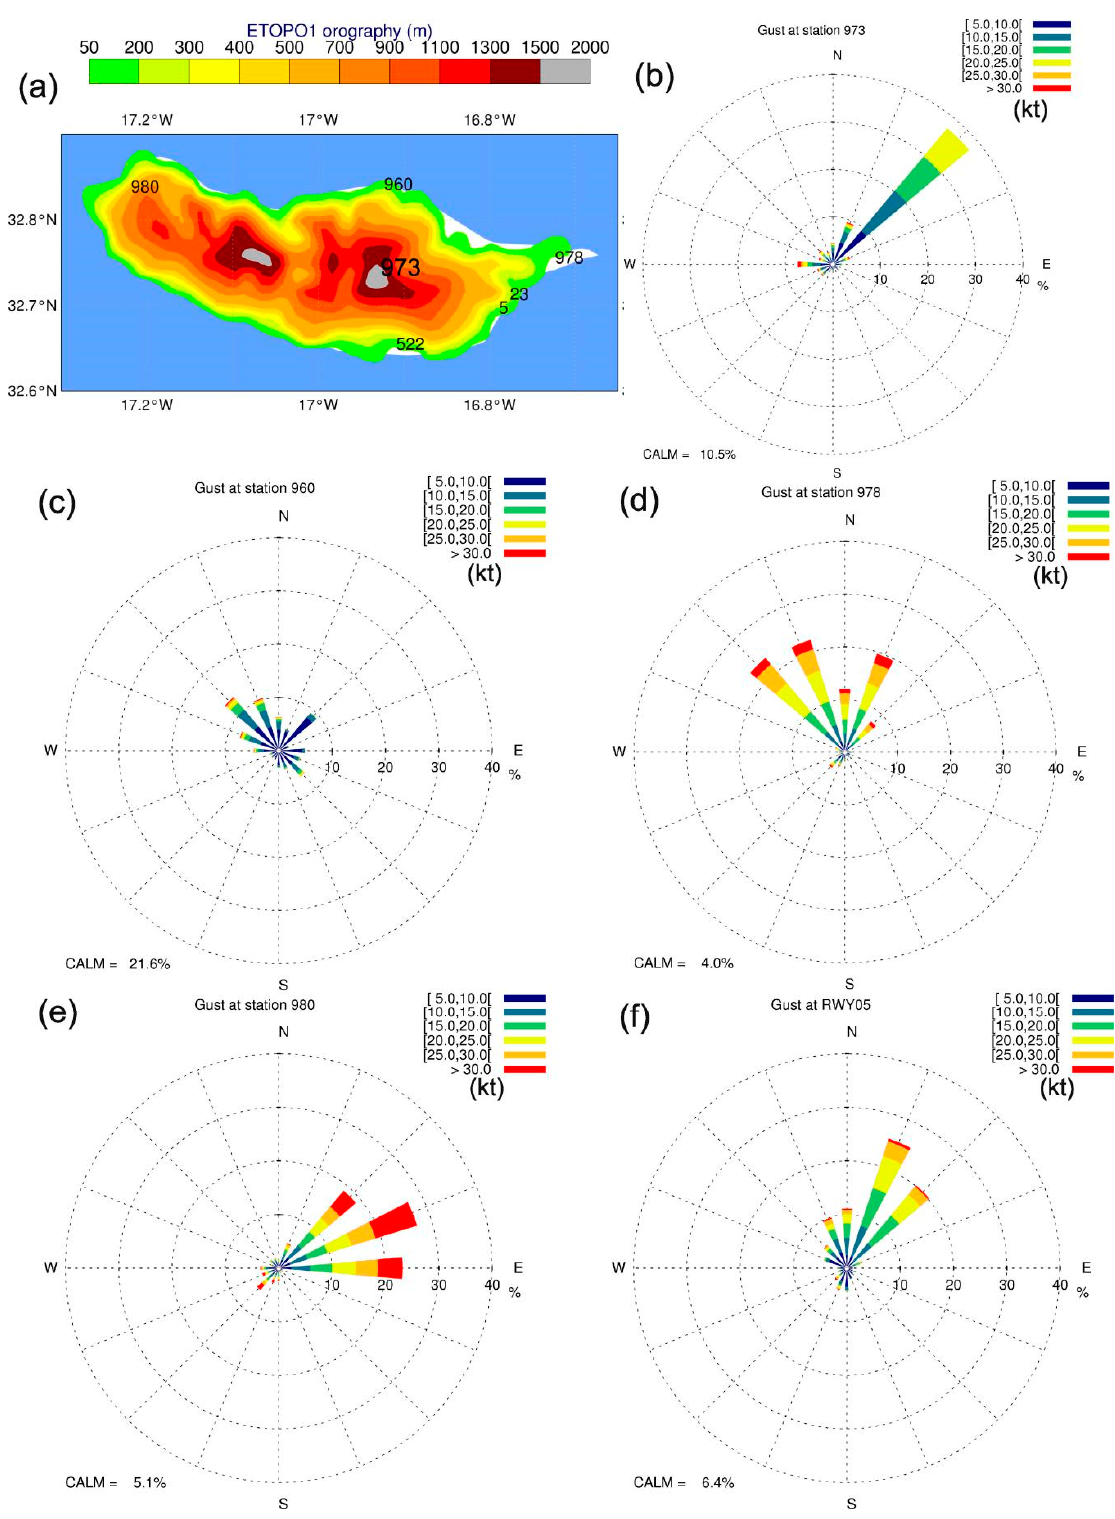
Figure 3. ( a ) Hypsometric chart of Madeira Island based on ETOPO1 orography (elevation in m). ( b– f ) Wind roses screening the relative frequencies of occurrence (in percent) of the wind gusts (in kt) in the extended summer period (April–September) and at the outlined locations of Madeira Island (b: Station 973, c: Station 960, d: Station 978, e: Station 980, f: RWY05). Figure 4 shows the wind roses for average 2-min wind for Rosario (RS) and three locations at the MIA (RWY05, MID and RWY23) during summertime, illustrating relevant differences between nearby locations (see Figure 1c). At the RS site, the wind prevails from NNW to NE, with maximum